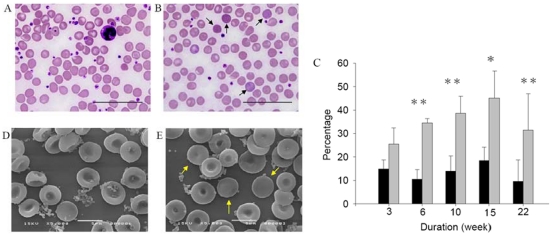
Morphology of RBCs from cellulose- (A, D) and garlic-supplemented (B, E) diet groups.RBCs were stained with Giemsa (week 6) to show darkly-stained cells (arrows in Panel B). (A) Most RBCs of control samples stained intensely around the edges rather than in the middle, reflecting their bi-concave shape. Among the uniform-sized RBCs are many small platelets and a neutrophil with a multi-lobed nucleus. (B) Darkly-stained RBCs in garlic-fed samples are non-nucleated, round or ovoid-shaped cells (arrows in Panel B) with almost the same size as the RBCs in control samples. They have more intense colors with a dark blue tint. (C) The % difference of darkly-stained cells at each time point (mean±s.e.m., n = 3–4, Brilliant Cresyl blue staining) between the two diet groups (control:black bars; garlic:gray bars) is significant (student's t test: *, p<0.05; **, p<0.01) throughout the time course. (D and E) SEM of RBCs (5000×) from control (D) and garlic-fed (E) mice (week 17). RBCs of garlic-fed samples contain more round-shaped cells (arrows in E) and those with a smaller dent at center. Scale bars: 100 µm (Panels A and B) or 5 µm (Panels D and E).